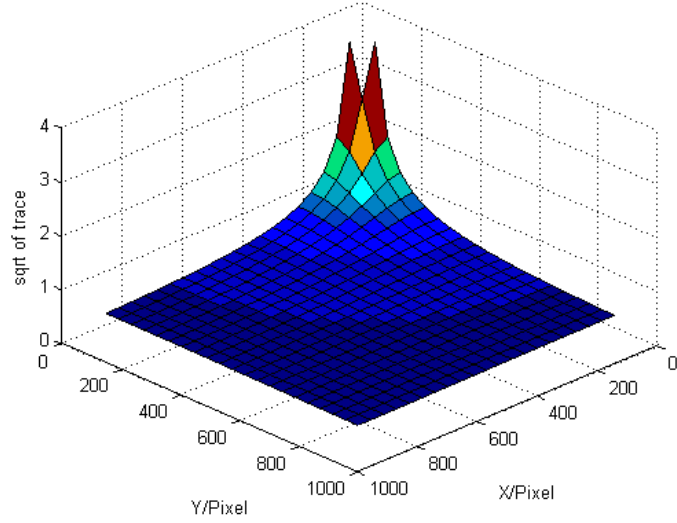
Figure 5. Simulation of the uncertainty.